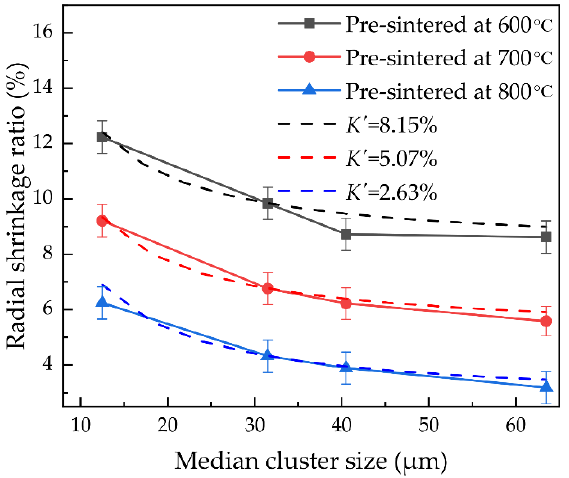
Figure 7. Radial shrinkage ratio versus median cluster size.